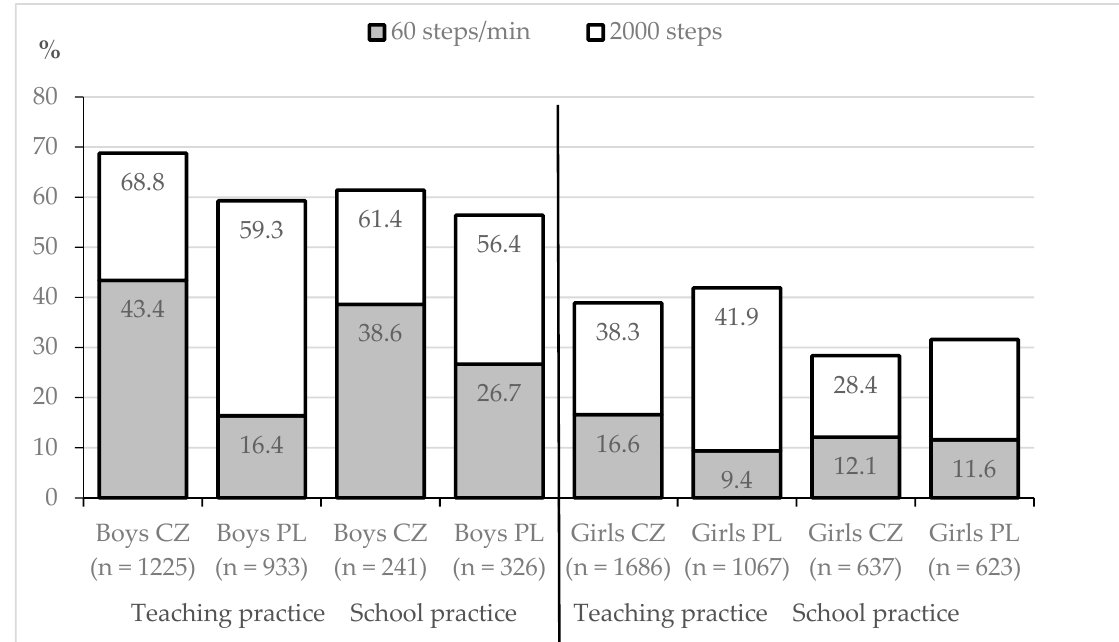
Figure 2. Achievement of the recommendation of 2000 steps and 60 steps/min in PE lesson (45 min) in teaching practice and school practice.